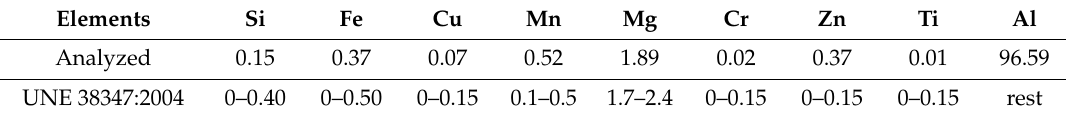
Table 1. Chemical composition (% by weight) of aluminum–magnesium substrate EN AW 5251 H34. Elements